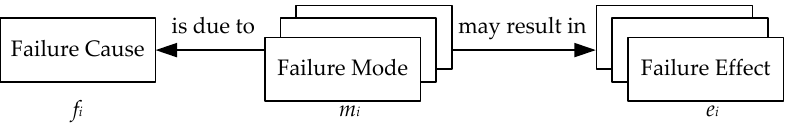
Figure 2. Relation between failure cause, modes, and effects.